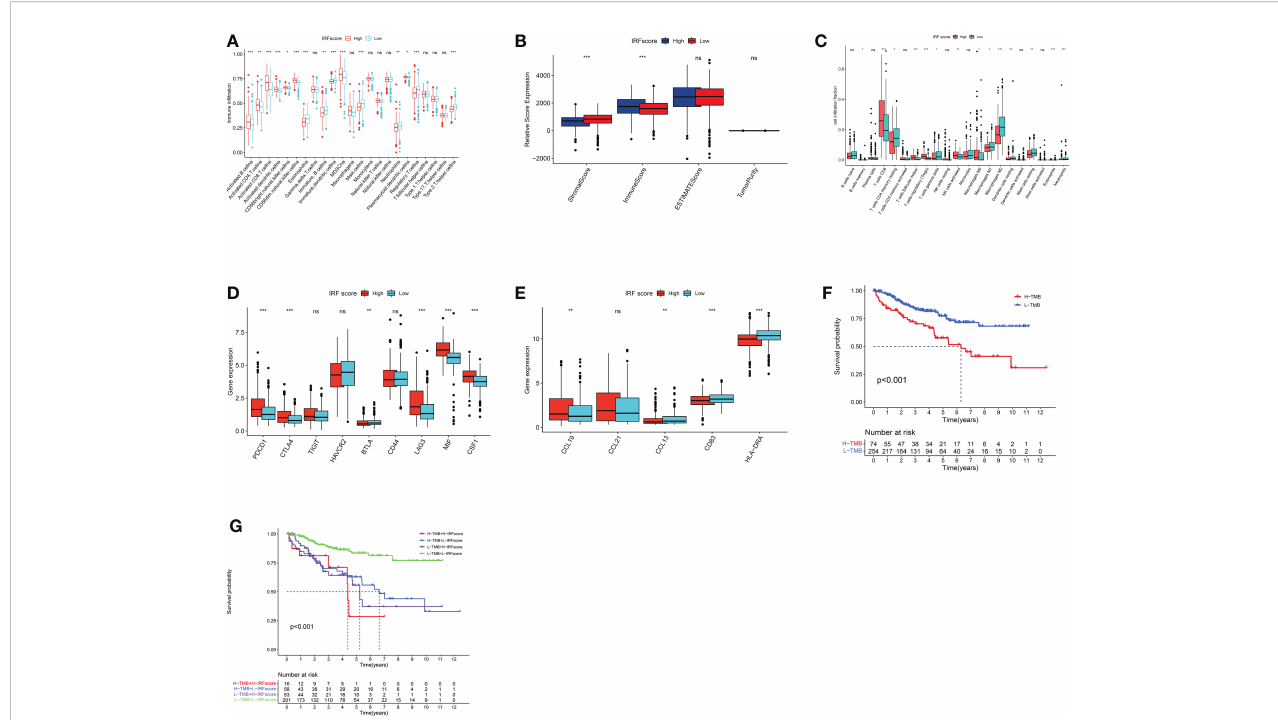
FIGURE 6 immune characteristics and somatic variants in IRFscore groups. (A) The abundance of each TME in fi ltrating cell in two IRFscore groups. (B) The immune scores, stromal scores and estimate score difference in high and low IRFscore groups. (C) The relative fraction of each TME-in fi ltrated cell in two IRFscore groups. (D) The differences in the receptors or ligands expressed by exhausted T cells between two IRFscore groups. (E) The differences in TLS- related markers between two IRFscore groups. (F) Kaplan-Meier survival analysis for two TMB score groups. (G) Kaplan-Meier survival analysis for patients strati fi ed by IRFscore and TMB score. ns, not signi fi cant; *p < 0.05; **p < 0.01; ***p < 0.001.